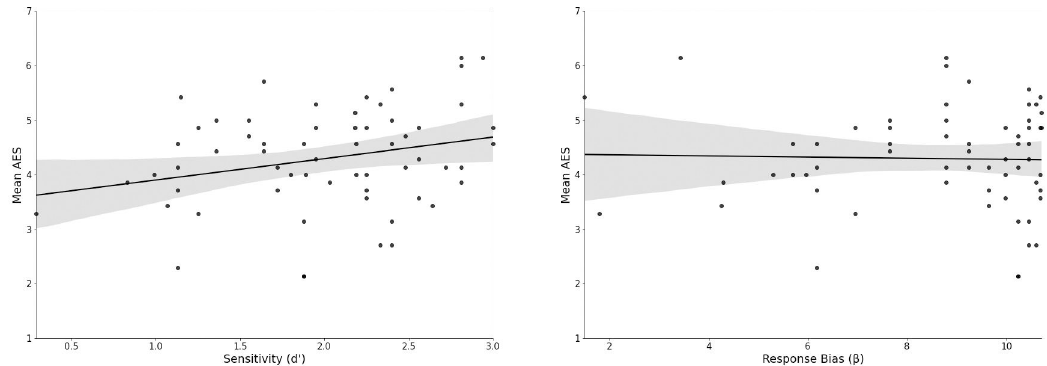
Fig 2. The relationship of AES with Signal Detection Theory measures of perceptual sensitivity and response bias. Scatterplots with confidence intervals demonstrating the relationship between AES and sensitivity (d’) and the lack of association between AES and response bias ( β ). Larger d’ values indicate greater tendency to differentiate signals from noise whereas larger β values correspond to a bias towards responding “No” (no voices present)